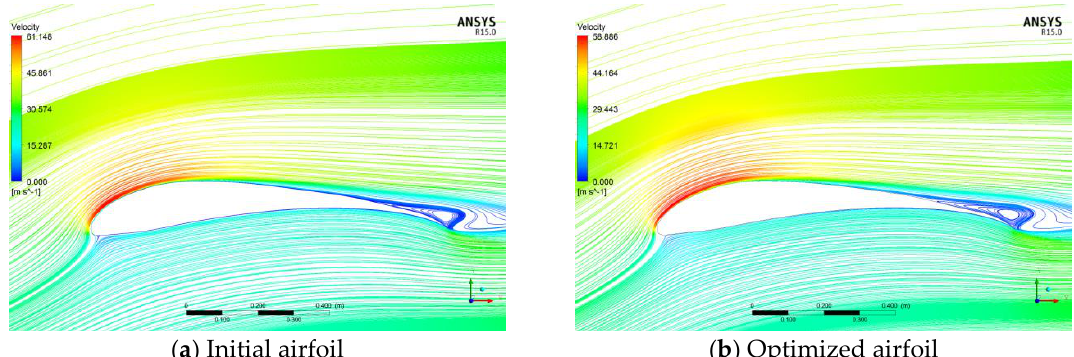
Figure 22. Velocity streamlines at the 12° angle of attack.